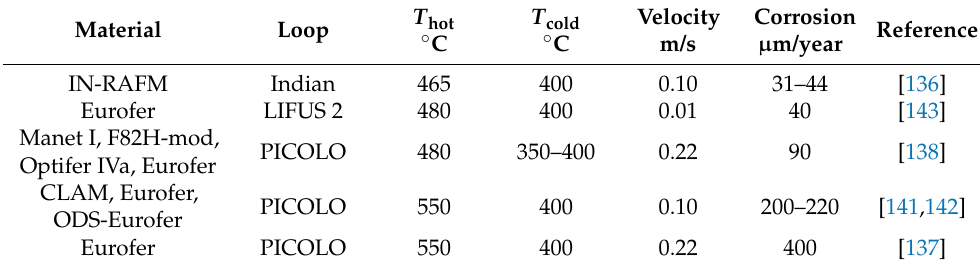
Table 3. Most relevant corrosion data of RAFM steels in flowing